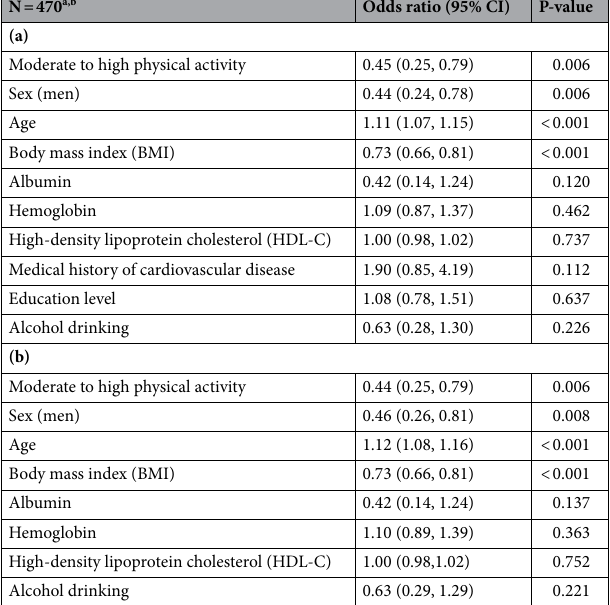
Table 4. Adjusted model for associated factors of sarcopenia in the study population according to the 2019 AWGS diagnostic criteria of sarcopenia after excluding institutionalized people. a Including all covariates as the whole 500 people model. b Just including covariates those existed group-difference when we did univariate analysis (no education level and medical history of cardiovascular